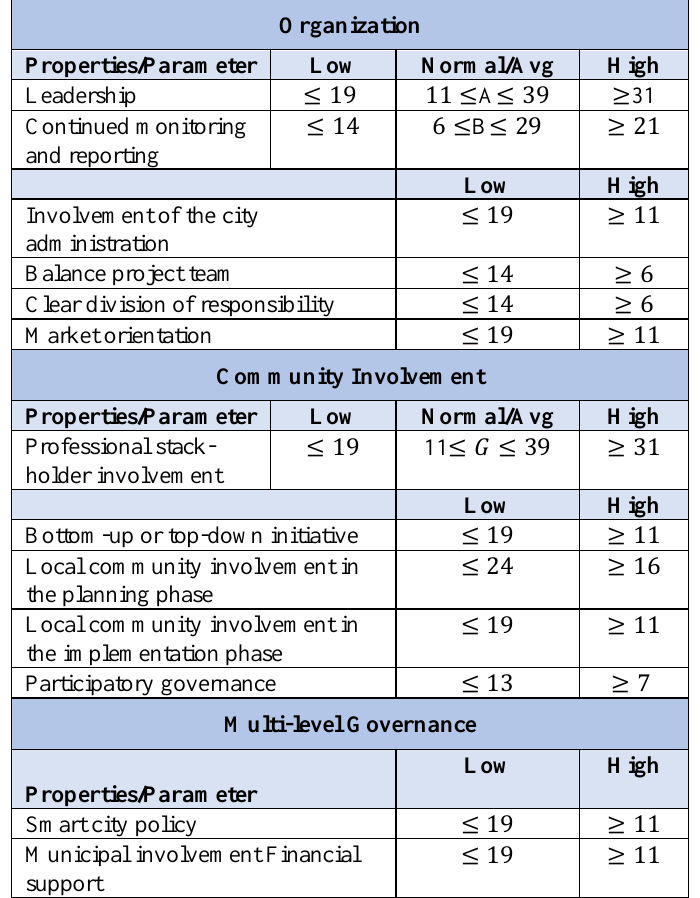
Table 1 . Input variable of proposed OGF-SCT-HMT-1-